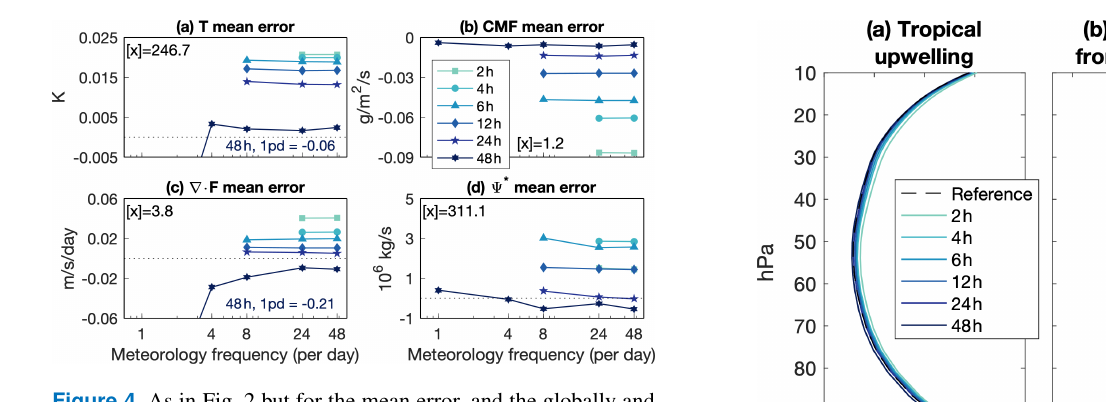
Figure 4. As in Fig. 2 but for the mean error, and the globally and vertically averaged absolute value of each field is shown in each panel.